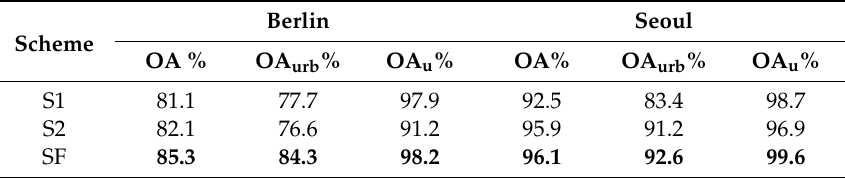
Table 4. Accuracy assessment results for S1, S2, and SF of Berlin and Seoul. The highest values of three accuracy metrics (OA, OA urb , and OA u ) are written in